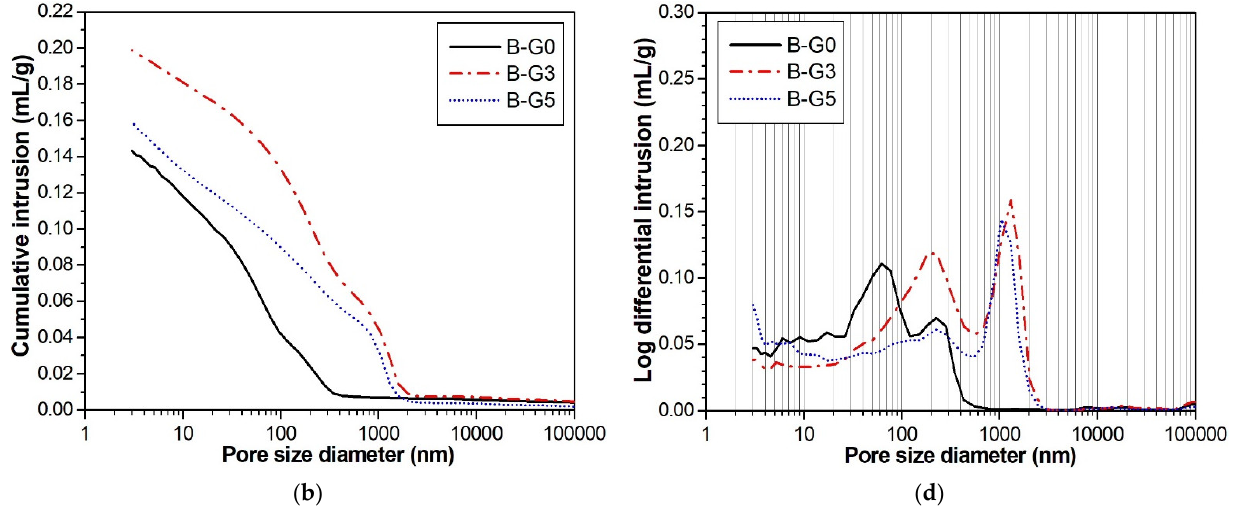
Figure 11. Pore size distribution curves of CSA cement pastes containing 0% (G0), 3% (G3), and 5% (G5) gypsum at 24 h. A: w/s ratio of 0.5; B: w/s ratio of 0.55. ( a , b ) for cumulative distribution; ( c , d ) for log differential distribution.